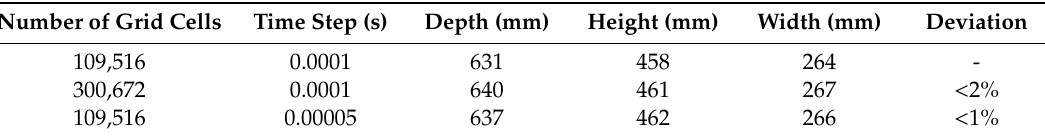
Table 5. Raceway size of di ff erent numbers of grid cells and time